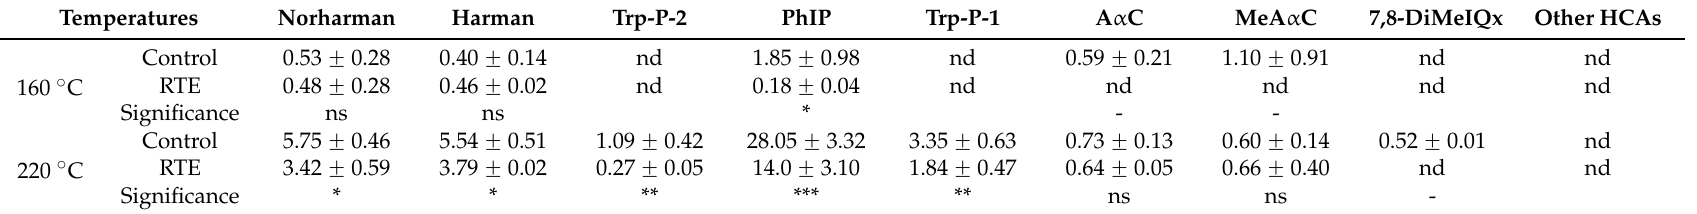
Table 1. Concentration of heterocyclic amines (ng/g) in beef patties with or without RTE fried at 160 °C and 220 °C